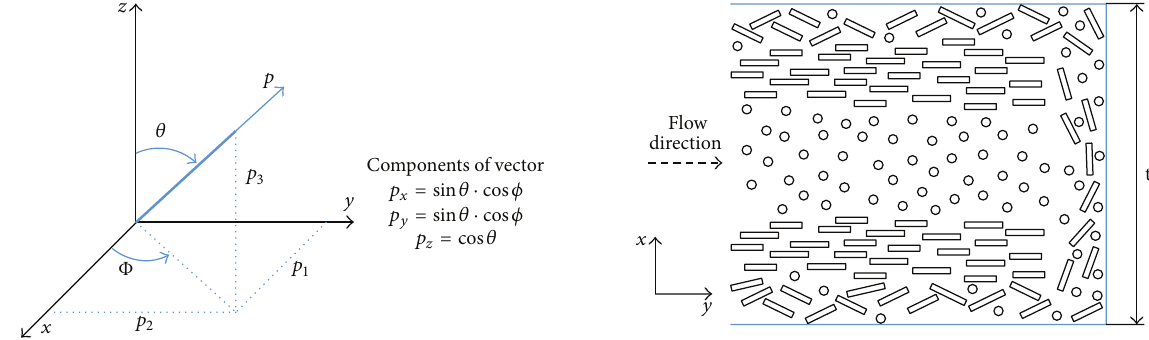
Figure 4: Fiber orientation in an injection molded plate depicted